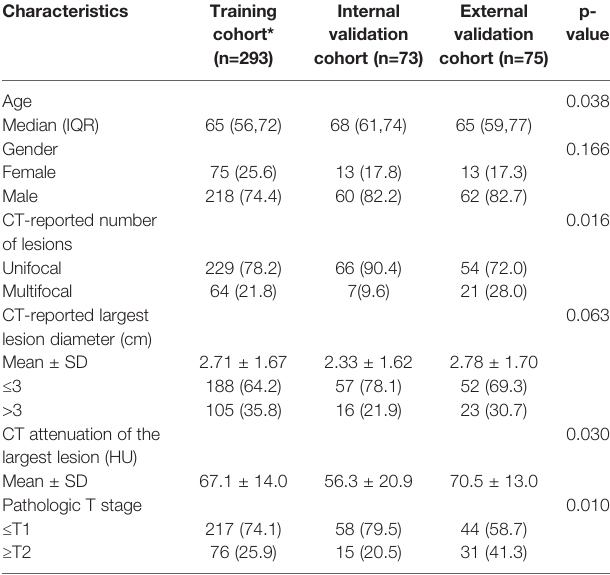
TABLE 1 | Clinical characteristics of patients with bladder